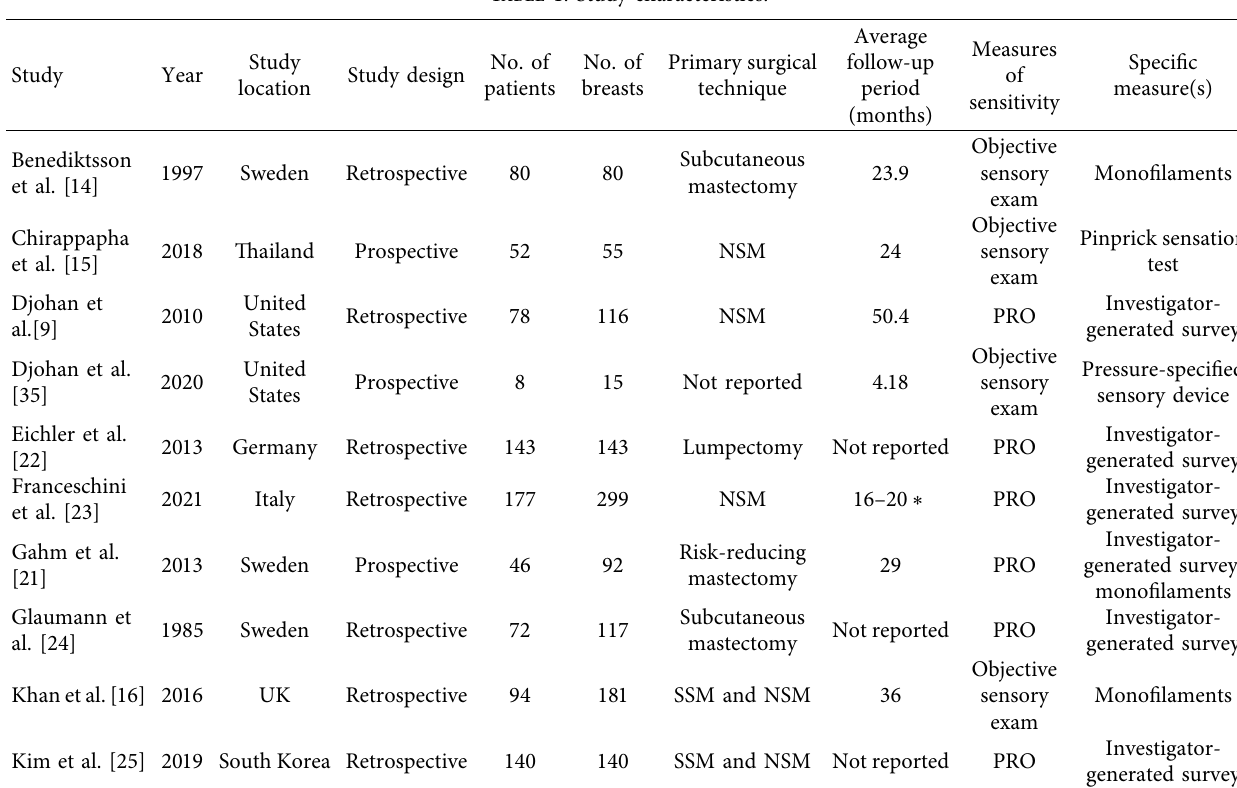
Figure 1: PRISMA Table 1: Study characteristics.